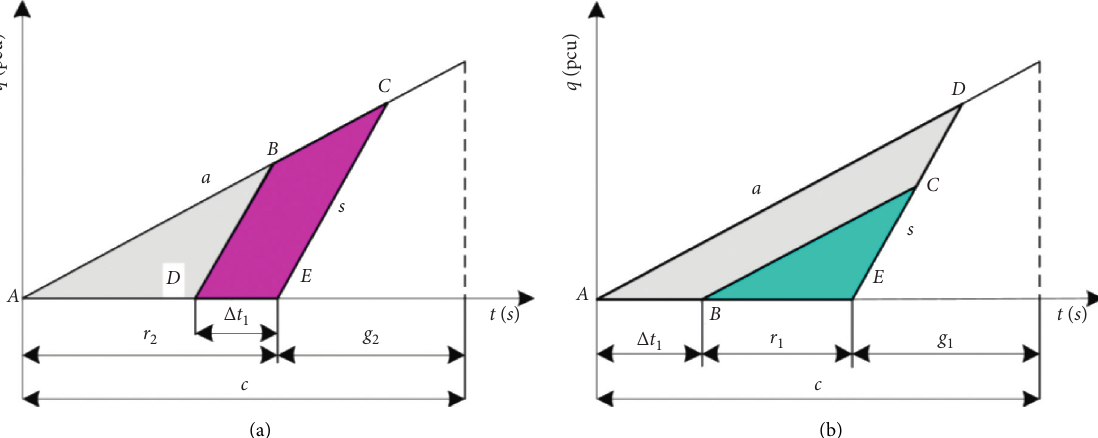
Figure 4: Delay variations when an overlapping phase is used. (a) Reduced delay of the through phase. (b) Increased delay in the approach of low volume left-turn